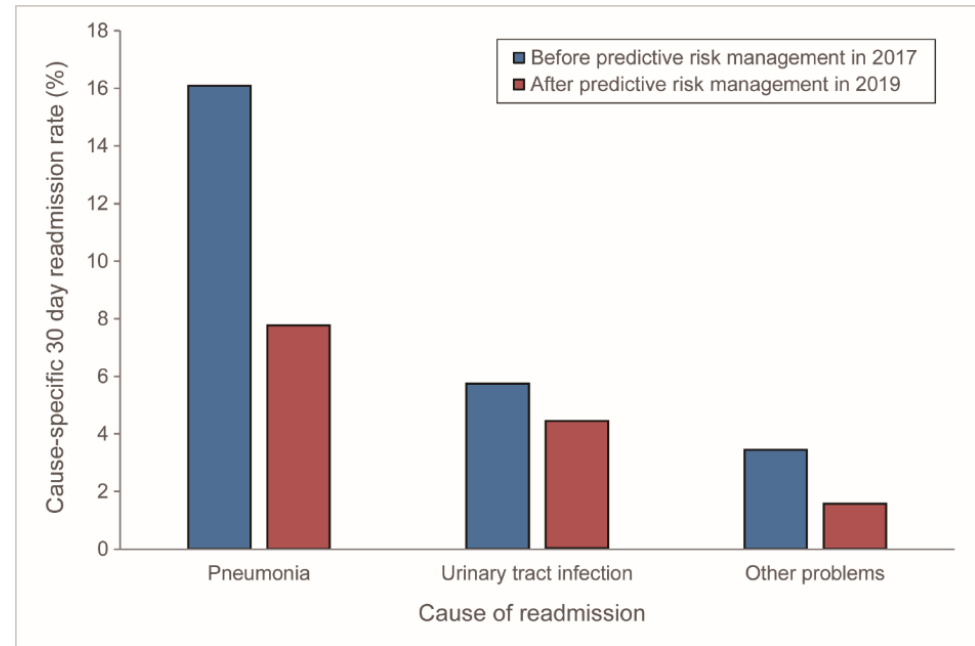
Figure 3. Cause-specific readmission rates by causes of readmission before (Pre-Implement) and after (Post-Implement) implementing LACE score-based predictive risk management tool to long-term home care patients of a medical center affiliated home care unit in Taiwan in 2017 and 2019. (Pre-Implement cohort in 2017, n = 87; Post-Implement cohort in 2019, n = 179).